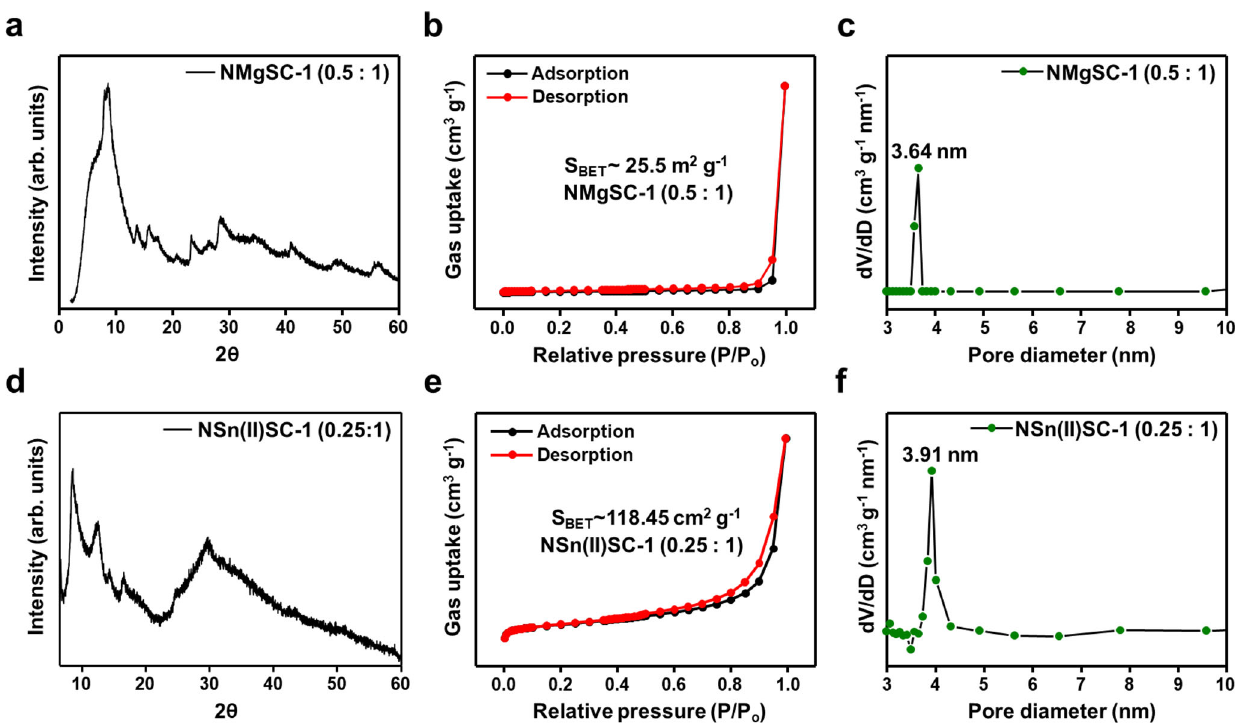
Fig. 4 | PXRD and porosity analyses of layered thiostannate chalcogels with various linkers (Mg 2+ and Sn 2+ ). a PXRD, b BET, and c BJH curves of Na-Mg-Sn-S (Mg 2+ :[Sn 2 S 6 ] 4 − =0.5:1, NMgSC-1). d PXRD, e BET,and f BJH curves of Na-Sn(II)-Sn(IV)-S(Sn 2+ :[Sn 2 S 6 ] 4 − =0.25:1, NSn(II)SC-1).Source dataare providedasaSource Data fi